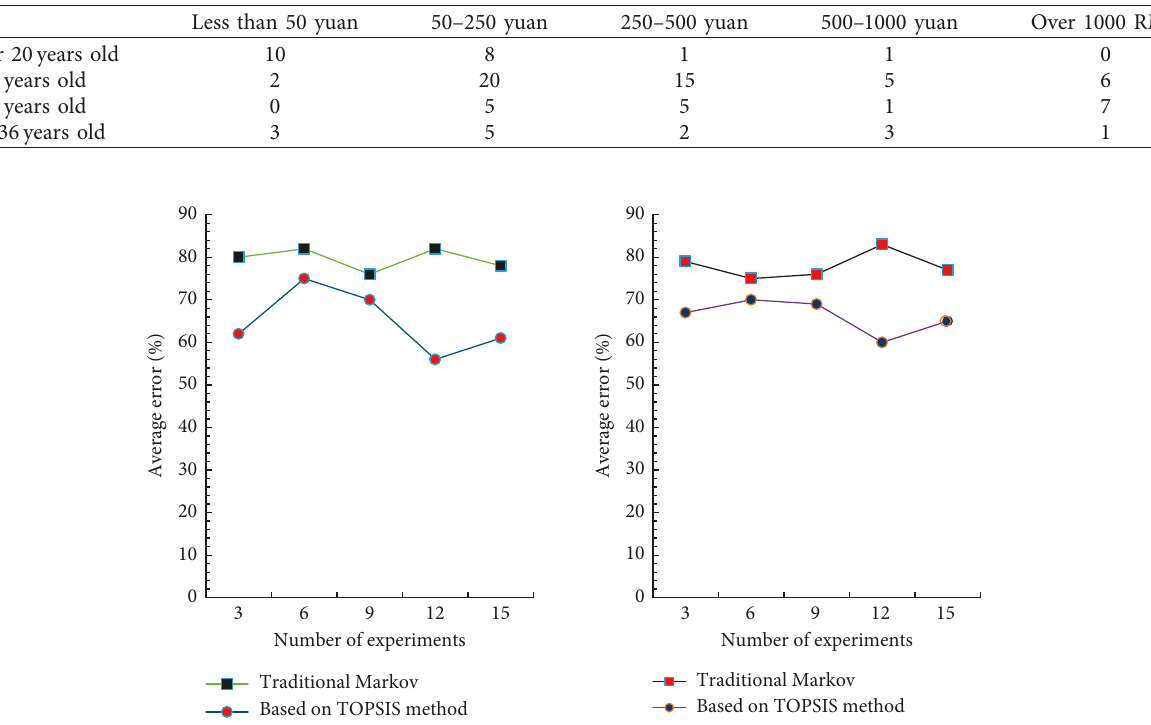
Figure 9: Comparison of forecast mean